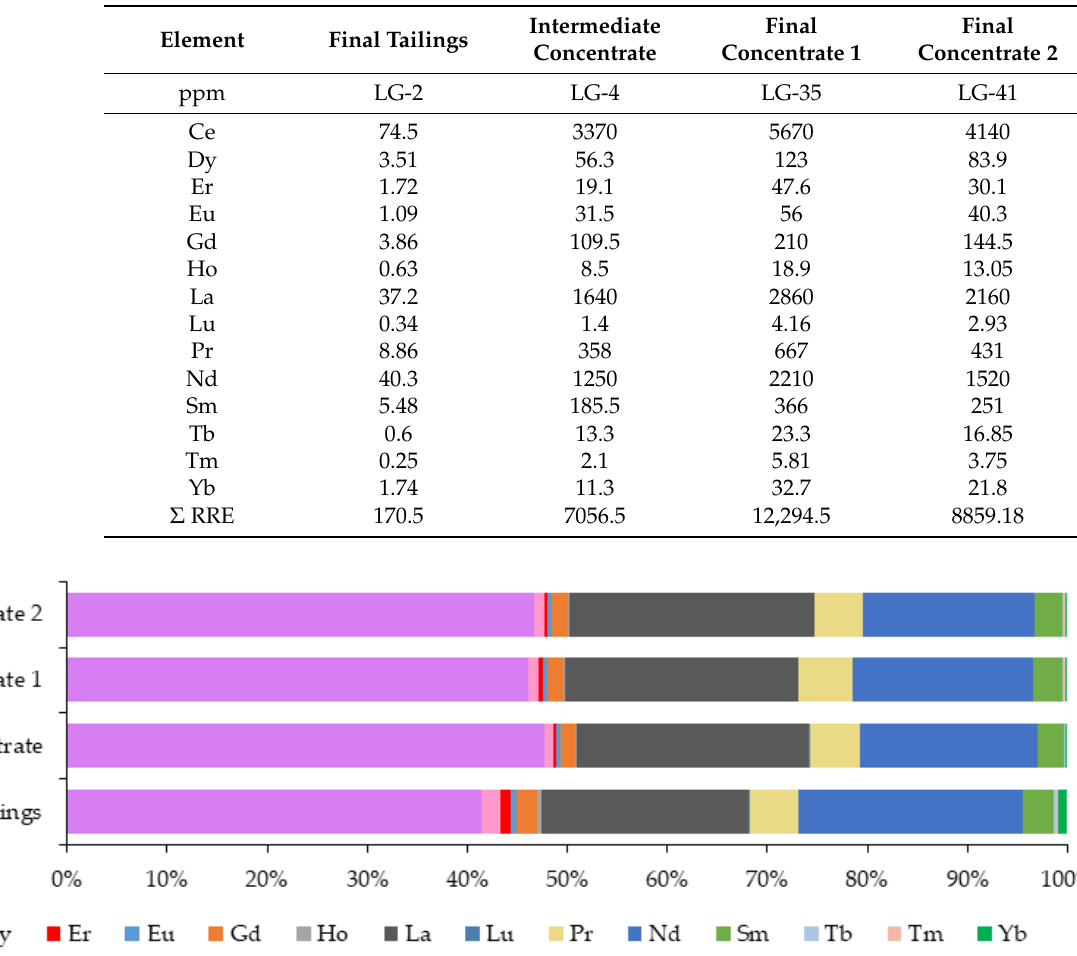
Table 2. REE elements in the tailings and processing products from the C-4 plant, in ppm.